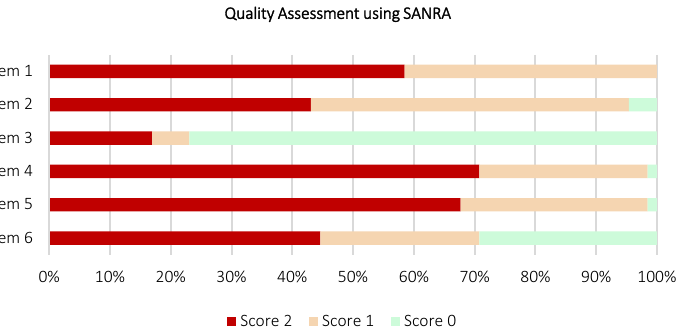
Figure 17. Quality assessment on 65 included review works (non-systematic review) using SANRA appraisal tool.